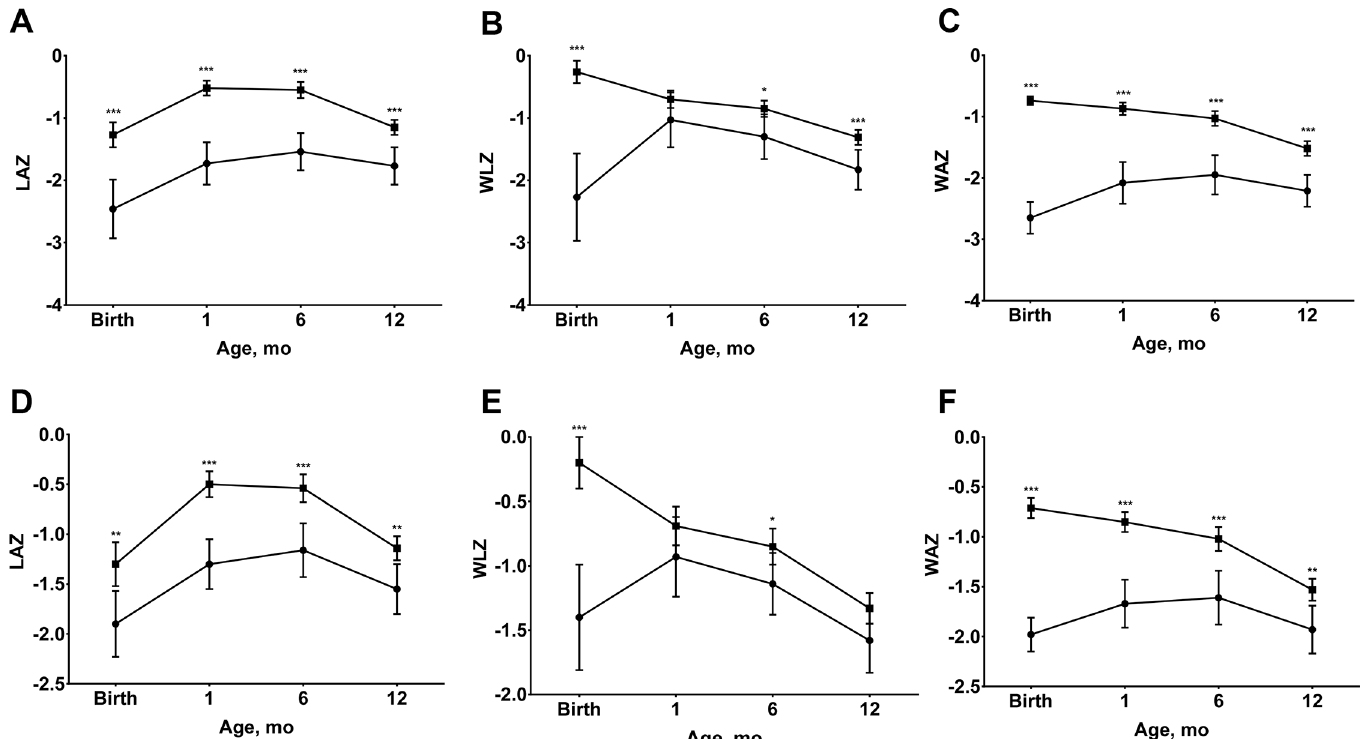
Fig 3. Length-for-age (LAZ), weight-for-length (WLZ) and weight-for-age (WAZ) z scores from birth to 12 months of age by birthweight (A, LAZ; B, WLZ; C, WAZ) and size for gestational age (D, LAZ; E, WLZ; F, WAZ). Values are means and 95% confidence intervals, n = 357. In A, B, and C, square symbols indicate low birthweight; circle symbols indicate non-low birthweight. In D, E, and F, square symbols indicate small-for-gestational age; circle symbols indicate non-small-for-gestational age. Low birthweight was defined as birthweight < 2.5kg. Small-for-gestational age was defined as birthweight < 10 th percentile for gestational age. * P < 0.05, ** P < 0.01, *** P < 0.001 different from low birthweight or small-for-gestational age